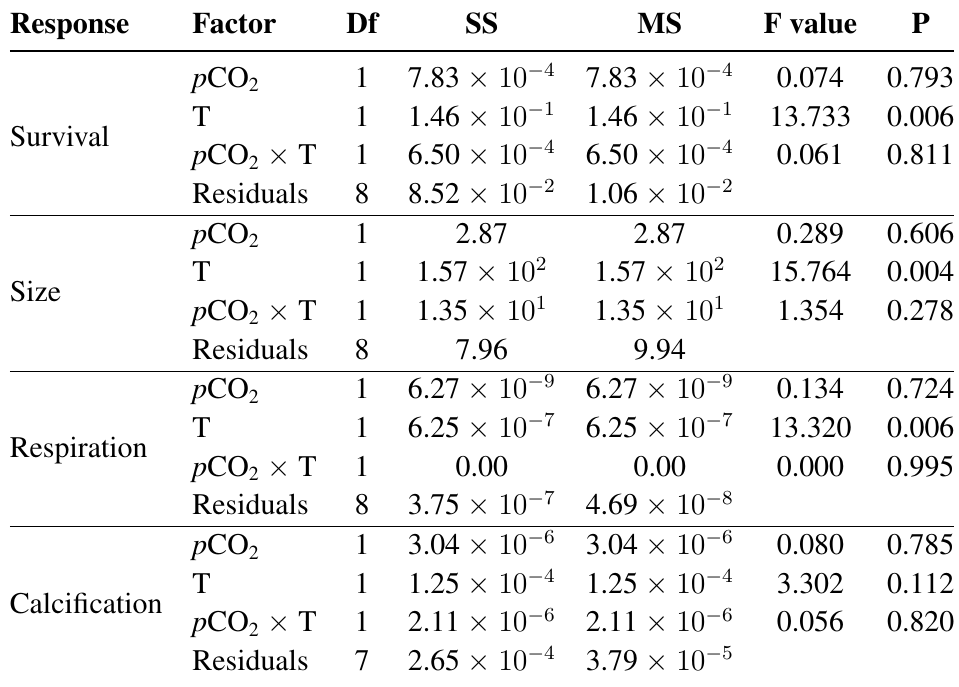
Table A1. Two-factor ANOVA results for the response parameters in the larval experiment. SS refers to sum of squares, MS to mean squares, T to temperature and p CO interaction